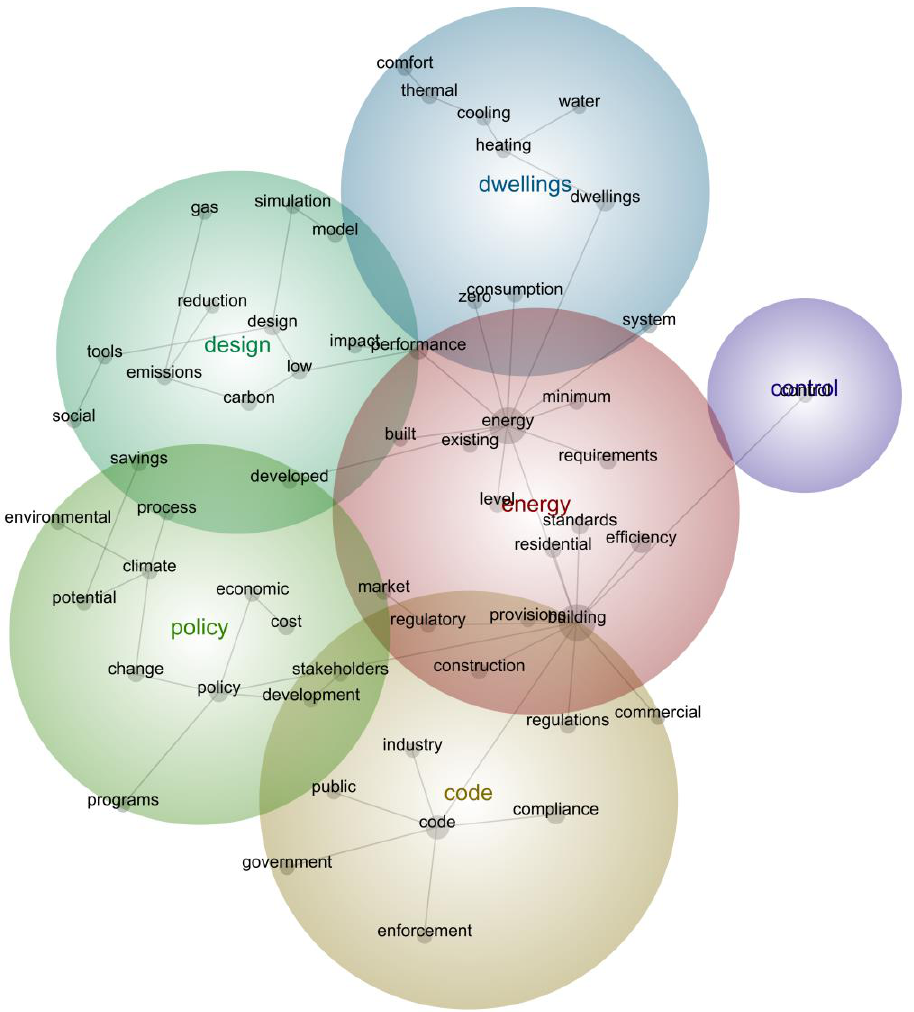
Figure 4. Themes and concept map from text mining analysis generated by Leximancer. Theme 1 (red)—Energy. Other than the self-explanatory concept “energy”, the